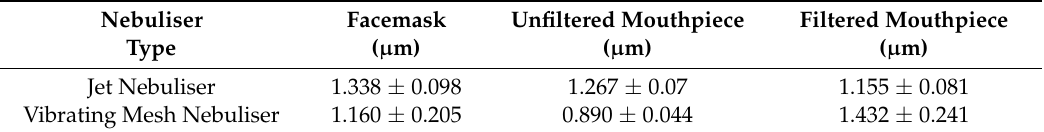
Table 3. Thirty-minute averaged aerosol concentration during each nebulisation event (using different facemasks and mouthpieces); mean and standard deviations over the three